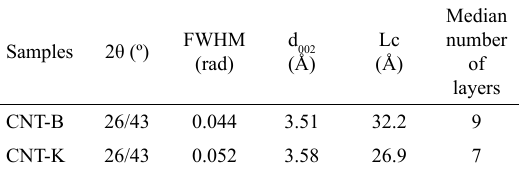
, Lc and number 002